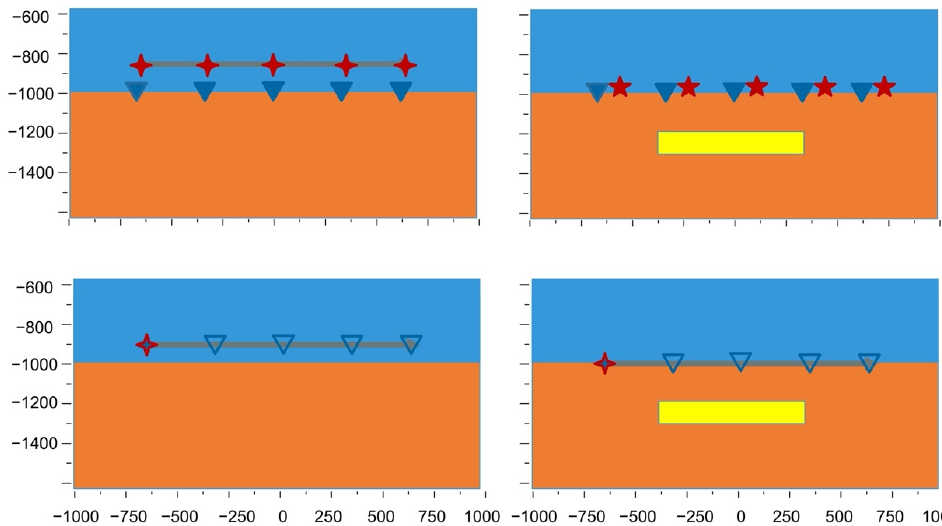
Figure 7. The background model with sea and overburden (blue and orange, left column) and model with embedded gas hydrate reservoir (yellow, right column); with stationary-receiver configuration with the seafloor receivers (closed triangles, top row); and towed-receiver configuration with fixed offset of 720 m, 960 m, 1200 m and 1440 m (open triangles, bottom row). The towed line is indicated by the grey line. The stationary source is indicated by the five-point red star. The towed source was 50 m above the seafloor (four-point star).